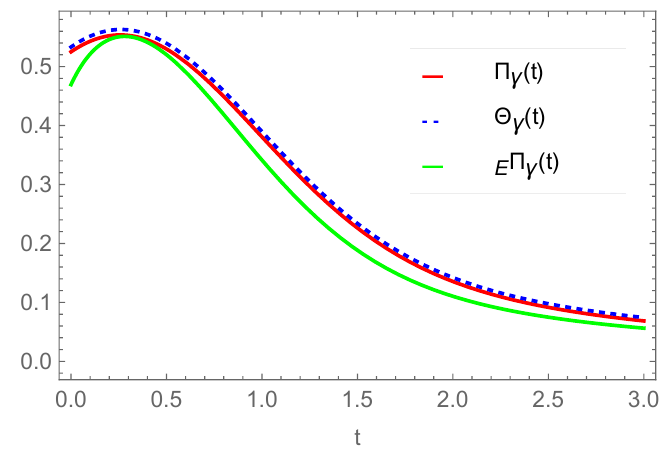
Figure 10. Solutions of Equation (58) for y 0 = 0, f ( τ ) = e − x 2 , γ = 0.5.